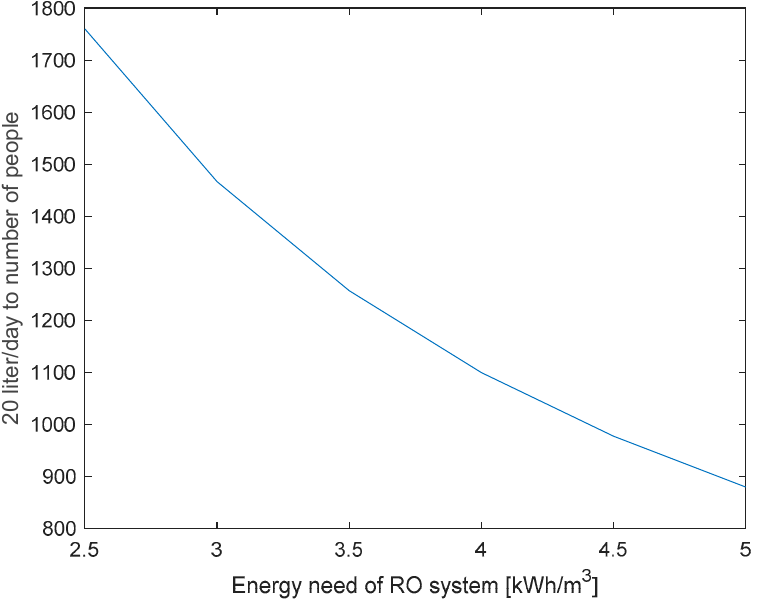
Figure 3. If the energy needed of the RO system for producing one cubic meter freshwater would vary (kWh/m 3 ), this affects the amount of people that could gain 20 L freshwater from one EV system.